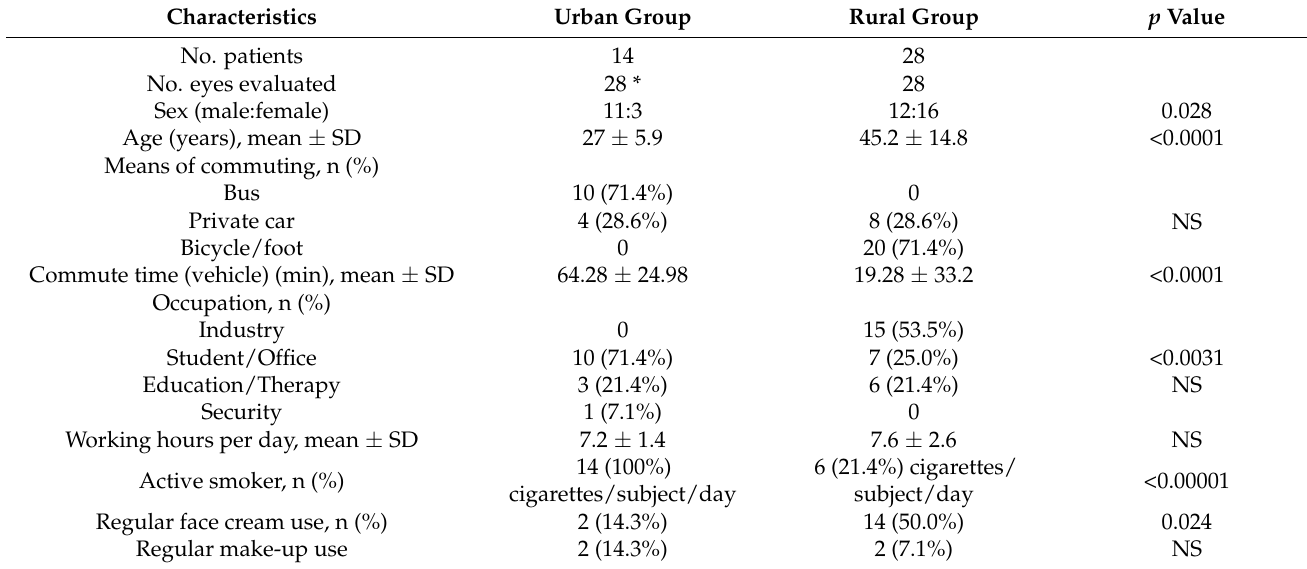
Table 1. Characteristics of subjects evaluated for tear film trace metals.